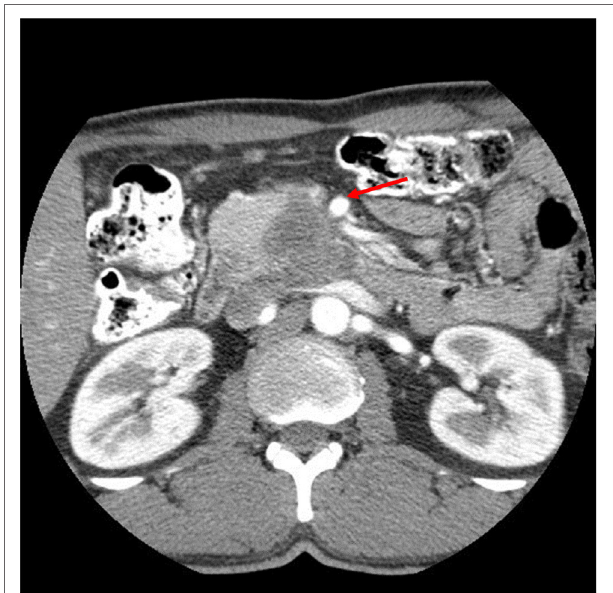
FIgURe 2 | CT abdomen at restaging following neoadjuvant chemo- radiation therapy showed a 3.3 cm × 3.1 cm mass, decreased from initial size with involvement of the SMA (see arrow) and SMV